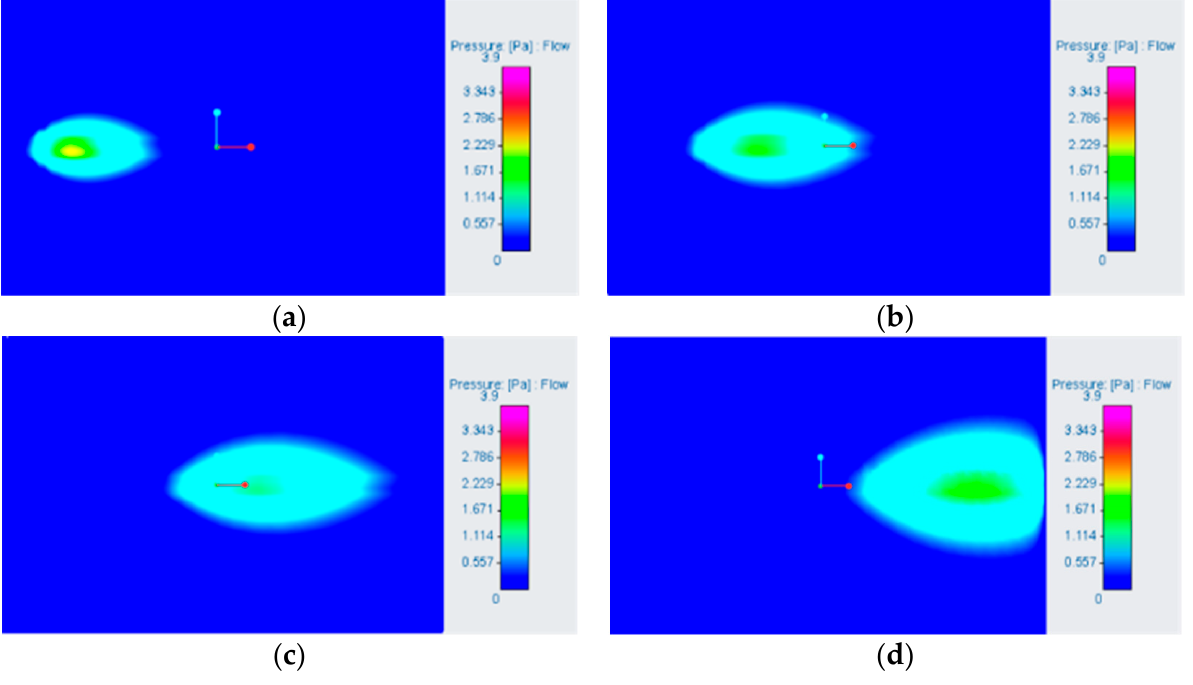
Figure 10. Pressure distribution diagram of each row of single pipes after the air outlet: ( a ) the second row of single longitudinal pipes; ( b ) the third row of single longitudinal pipes; ( c ) the fourth row of single longitudinal tubes; ( d ) the fifth row of single longitudinal tubes.